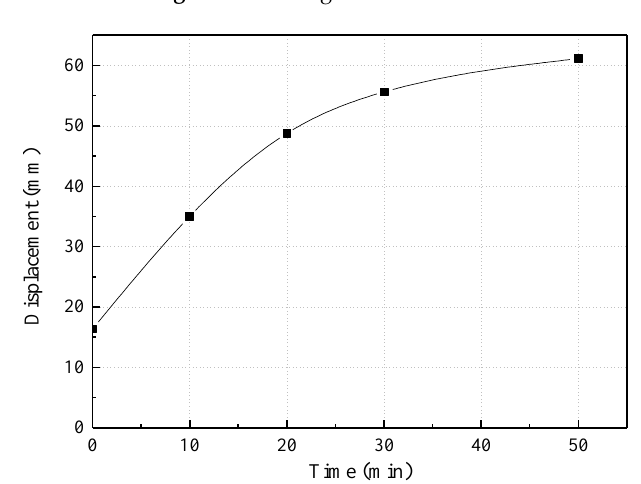
Figure 8. Loading curve with time. Appl. Sci. 2020 , 10 , x FOR PEER REVIEW